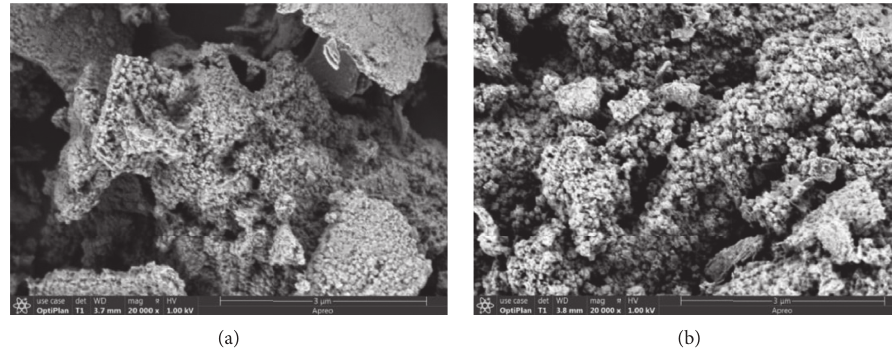
Figure 3: SEM images of EA-CuHCF before (a) and after (b)